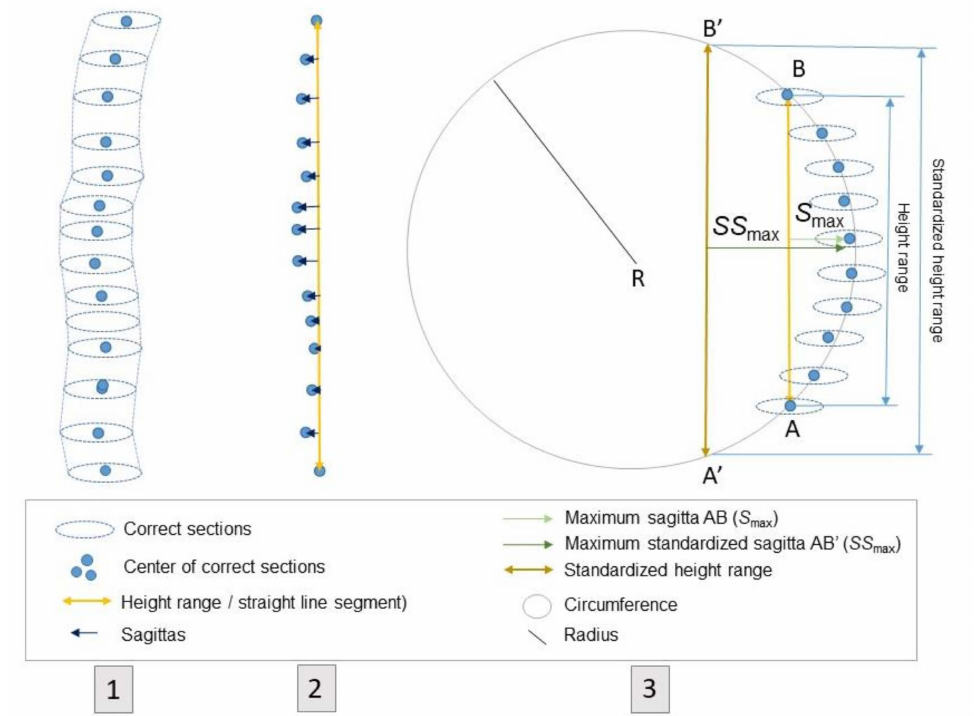
Figure 4. ( 1 ) Stem sections defined by their center ( X , Y , Z ) and radius. ( 2 ) Sagittas calculated for each stem section, defined as the distance from the center of the section to the straight line segment. ( 3 ) Maximum standardized sagitta calculation considering the centers of the sections to be distributed around a circumference of radius R